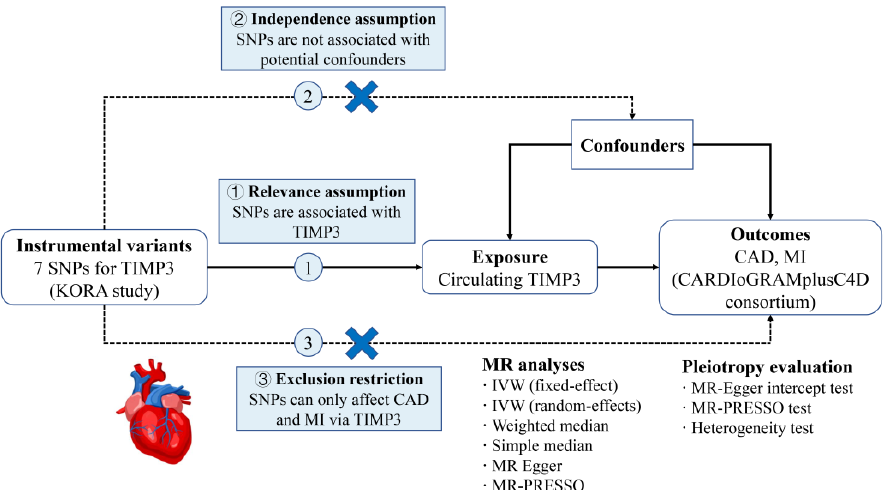
Figure 1. Schematic diagram of the present Mendelian randomization study. SNPs, single − nucleotide polymorphisms; TIMP3, tissue inhibitors of matrix metalloproteinase 3; CAD, coronary artery disease; MI, myocardial infarction; KORA, Cooperative Health Research in the Region of Augsburg; CARDIoGRAMplusC4D, Coronary Artery Disease Genome − Wide Replication and Meta − Analysis plus the Coronary Artery Disease Genetics; IVW, inverse − variance weighted; MR − PRESSO, MR Pleiotropy Residual Sum and